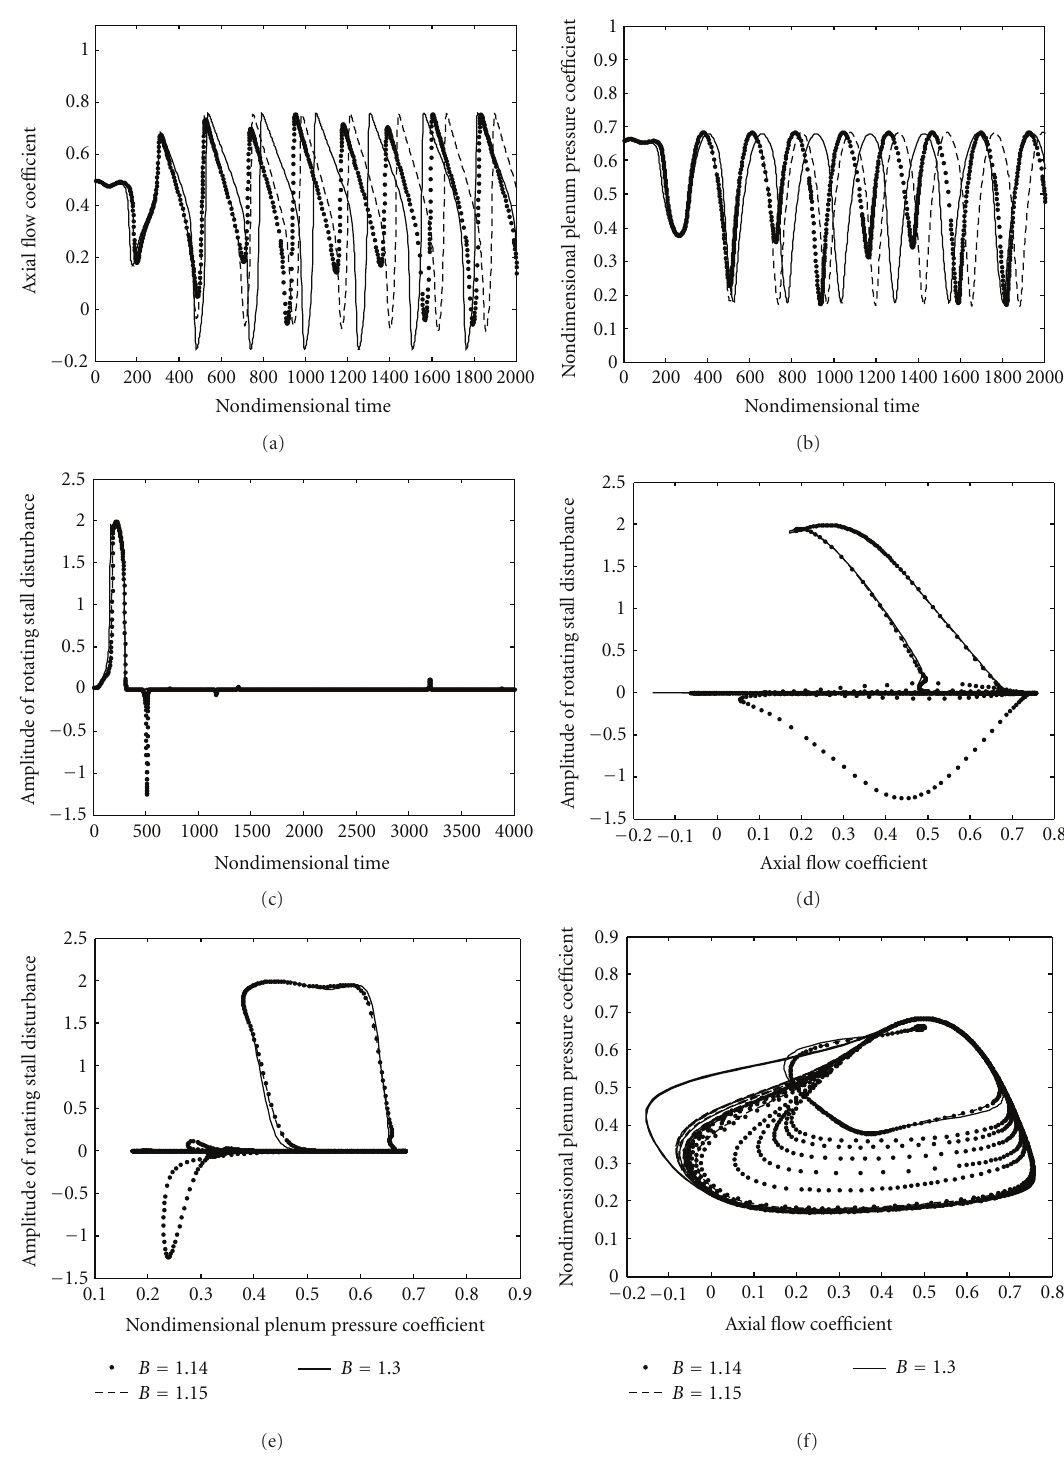
Figure 14: E ff ect of increase in B parameter from 1.14 to 1.3: variation of nondimensional flow properties (a), (b), and (c) with time. (a) Axial flow coe ffi cient. (b) Plenum pressure rise coe ffi cient, and (c) disturbance amplitude of rotating stall. (d) Variation of axial flow coe ffi cient with disturbance amplitude of rotating stall. (e) Variation of plenum pressure rise coe ffi cient with disturbance amplitude of rotating stall. (f) Limit cycle oscillation: axial flow coe ffi cient versus plenum pressure rise coe ffi